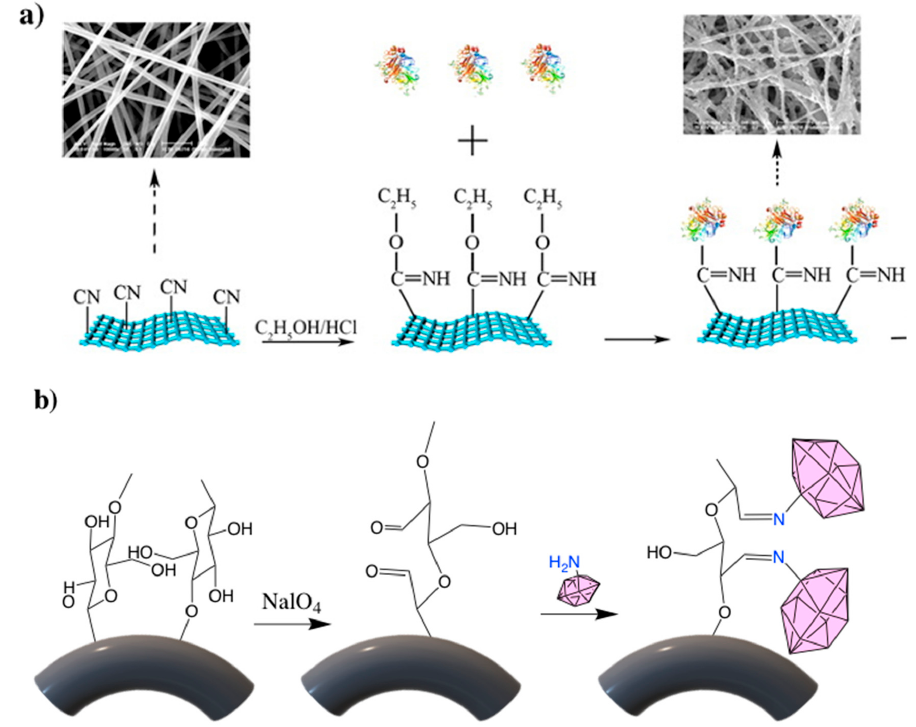
Figure 7. ( a ) Schematic of surface modification of PAN nanofibers using amidination reaction. Reproduced with permission from [67]. Copyright American Chemical Society, 2013. ( b ) Schematic of cellulose derivatives using sodium